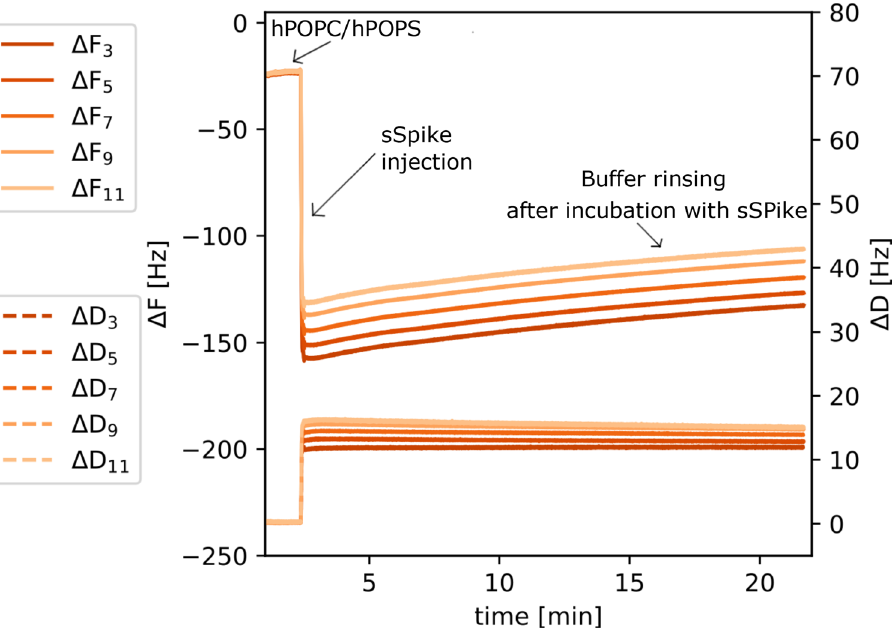
Figure 2. QCM-D data collected during the injection of sSpike solution (0.468 mg/mL) on a supported lipid bilayer from hPOPC:hPOPS:sACE2. The supported bilayer was prepared by deposition of hPOPC/hPOPS peptide discs, previously incubated with sACE2 (0.1